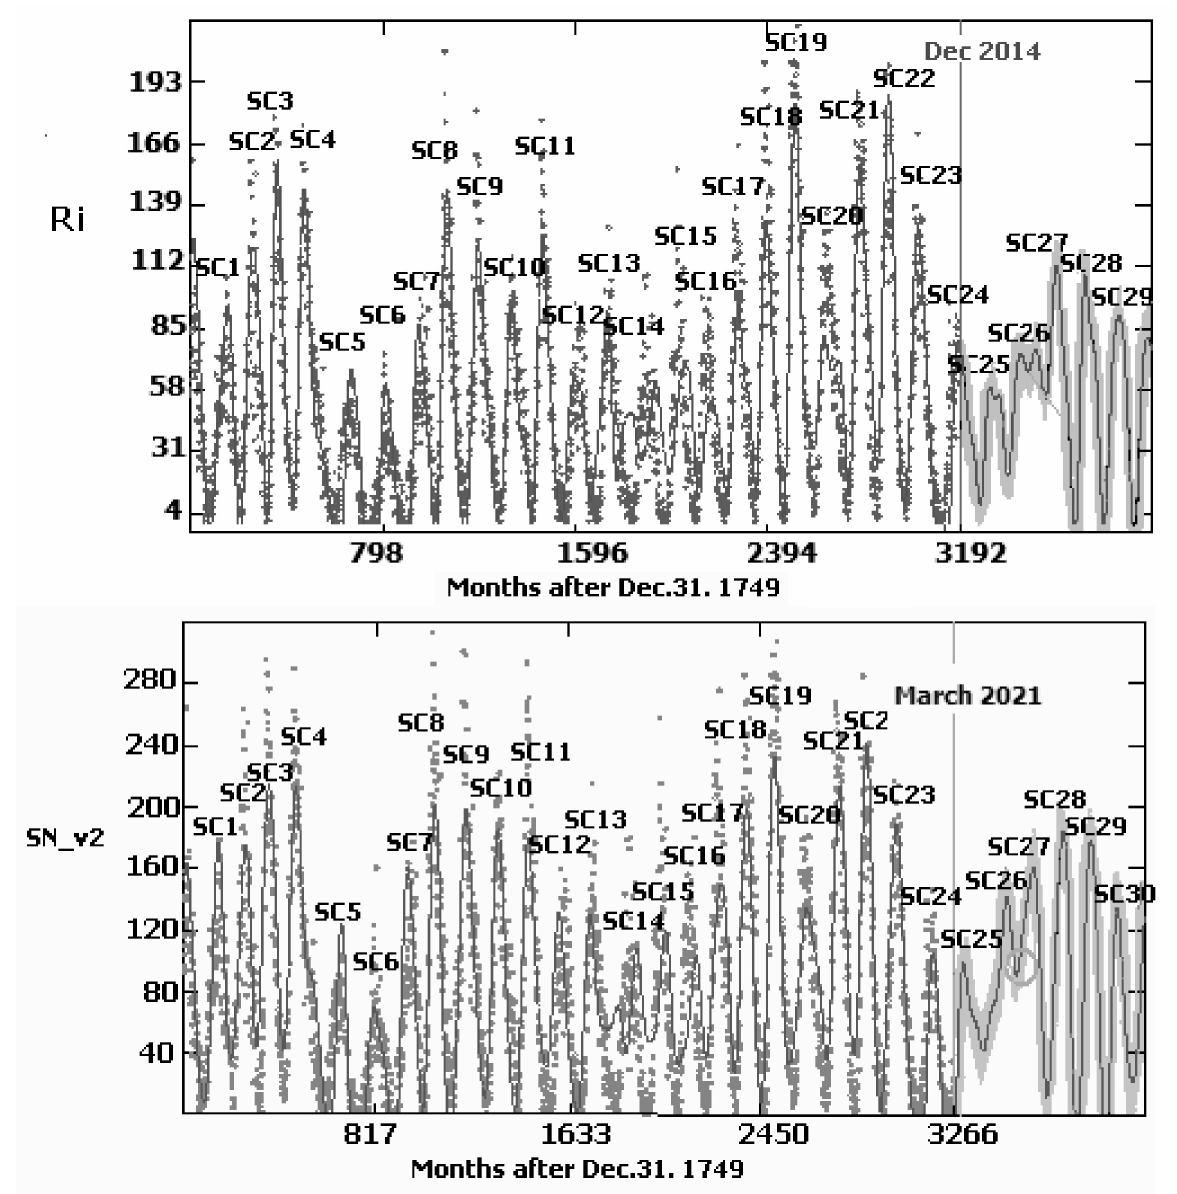
Figure 9. Kinematic model of Zurich sunspot series (old version ( upper panel ): January 1749–December 2014) on the basis of T – R periodogramm analysis and its extrapolation up to SC30 maximum (~2080 AD); (the new version ( lower panel ): January 1749–March